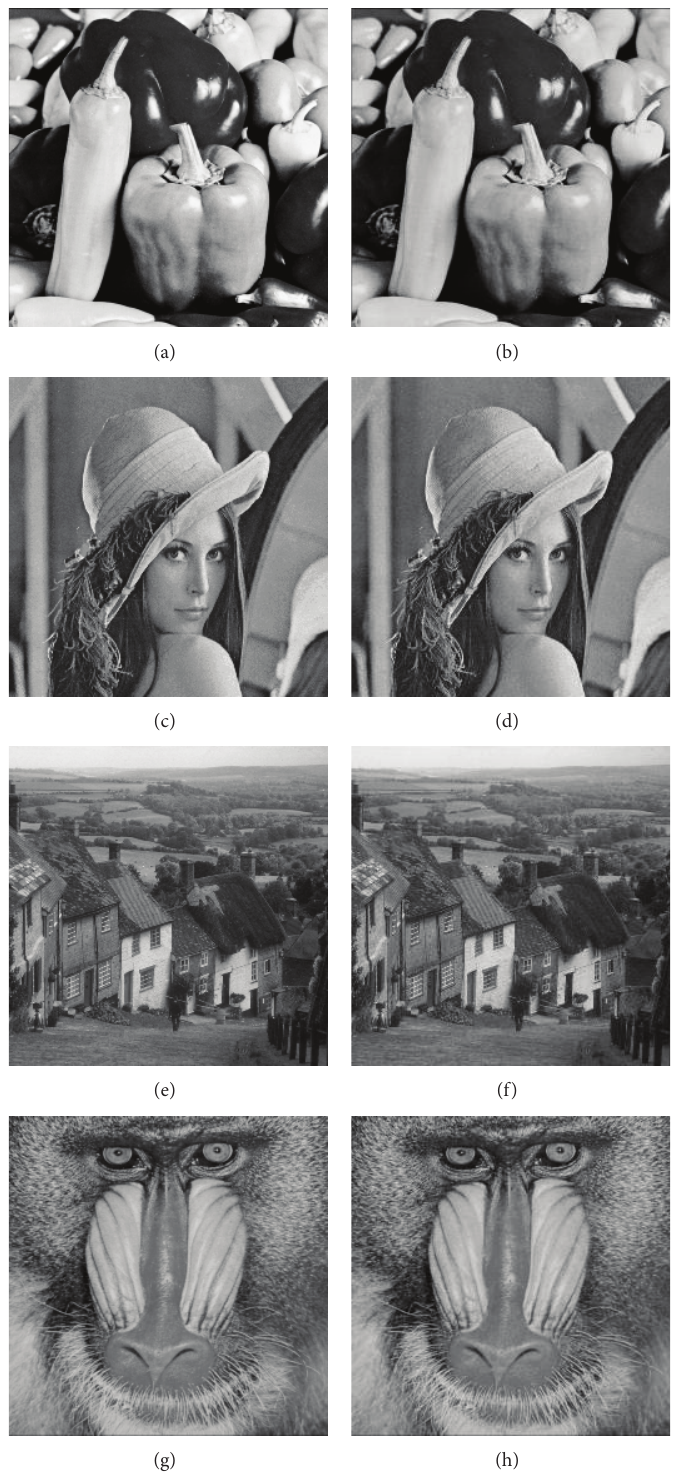
Figure 4: Original standard testing images and their reconstructed images. (a) Original Image “Peppers” (b) Reconstructed Image “Peppers” (PSNR = 52.94 dB) (c) Original Image “Lena” (d) Reconstructed Image “Lena” (PSNR = 54.04 dB) (e) Original Image “Goldhill” (f) Reconstructed Image “Goldhill” (PSNR = 54.64 dB) (g) Original Image “Mandrill” (h) Reconstructed Image “Mandrill” (PSNR = 53.82